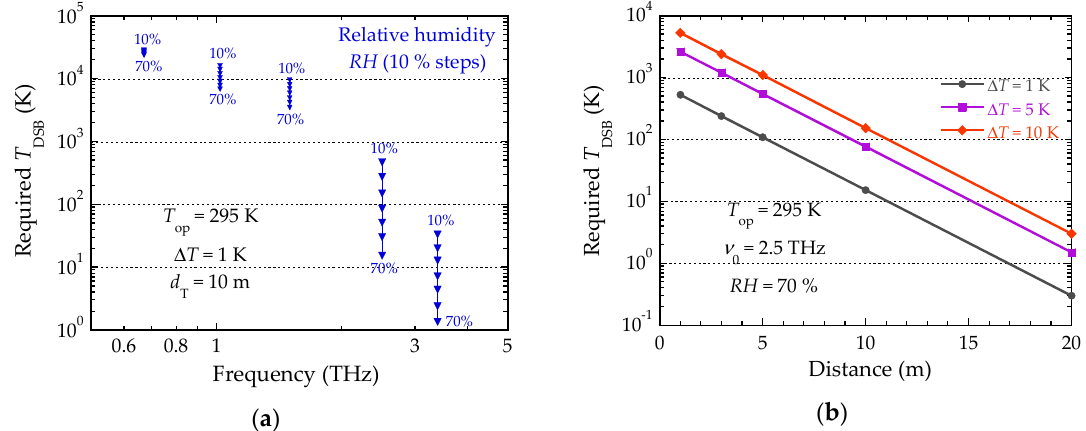
Figure 11. Standoff detection double sideband noise temperature requirements: ( a ) As a function of operating frequency for various atmospheric humidity contents (at fixed Δ T and d T ); ( b ) as a function of target distance for various target temperature resolutions (at fixed ν 0 and RH ).